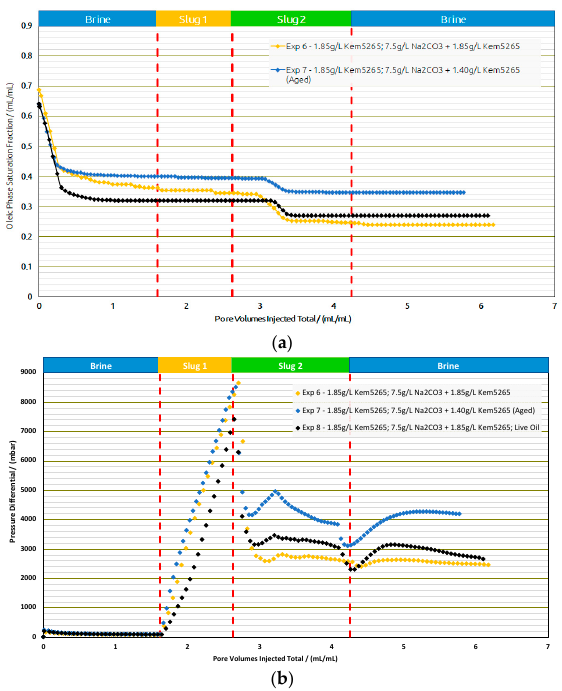
Figure 16. Oleic-phase saturation fraction/Pressure differential versus pore volumes injected total for the different slugs for core floods in real rock sand packs. Exp. 6 and 7 performed with dead oil and Exp. 8 with live oil. ( a ) Reduction in oleic-phase saturation versus PV of slugs injected in Berea outcrops with crude dead oil initialization. ( b ) Pressure variation versus PV of injected slugs in Berea outcrops with dead oil initialization.